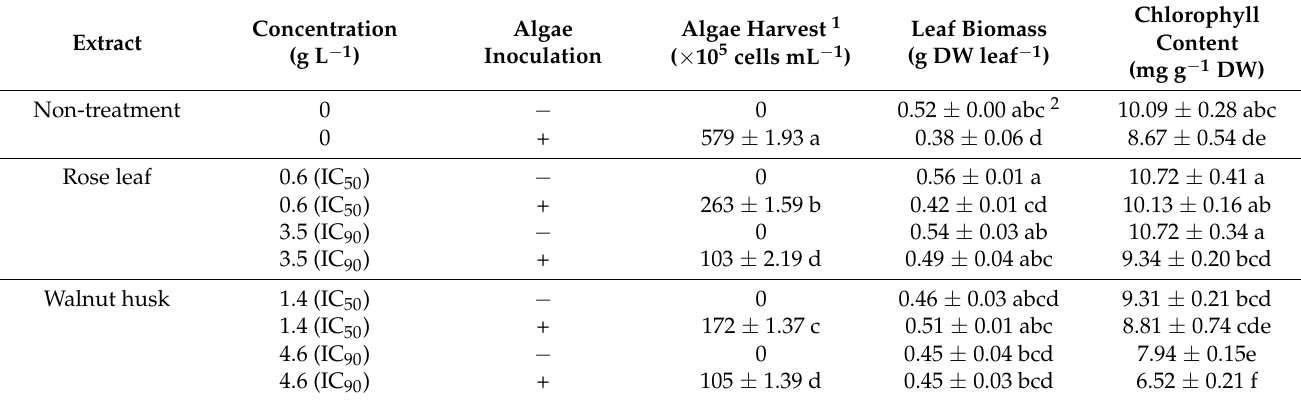
Table 3. Leaf growth and chlorophyll content of perilla grown under algae-free and -treated hydroponic media with non-treatment, rose leaf, and walnut husk extract.